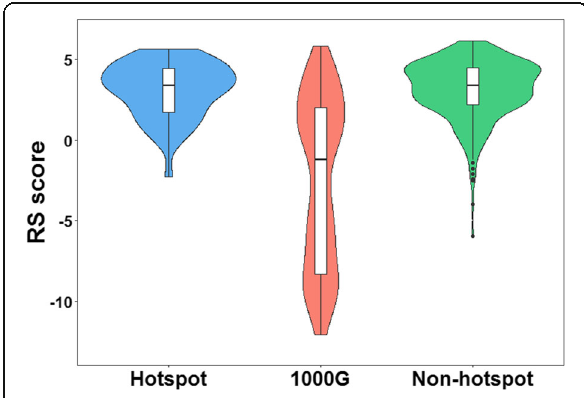
Fig. 5 Comparison of RS scores between the datasets of hotspots and neutral synonymous mutations, non-hotspots. Hotspot represents hotspot mutations; 1000G represents neutral synonymous mutations of HMCGs in 1000G dataset; Non-hotspot represents non- hotspot mutations of HMCGs in TCGA dataset. The RS score of hotspot mutation dataset is significant higher than that neutral synonymous mutation dataset ( p -value <2e-16). But there is no significant different between hotspot and non-hotspot datasets ( p - value = 0.93) for RS